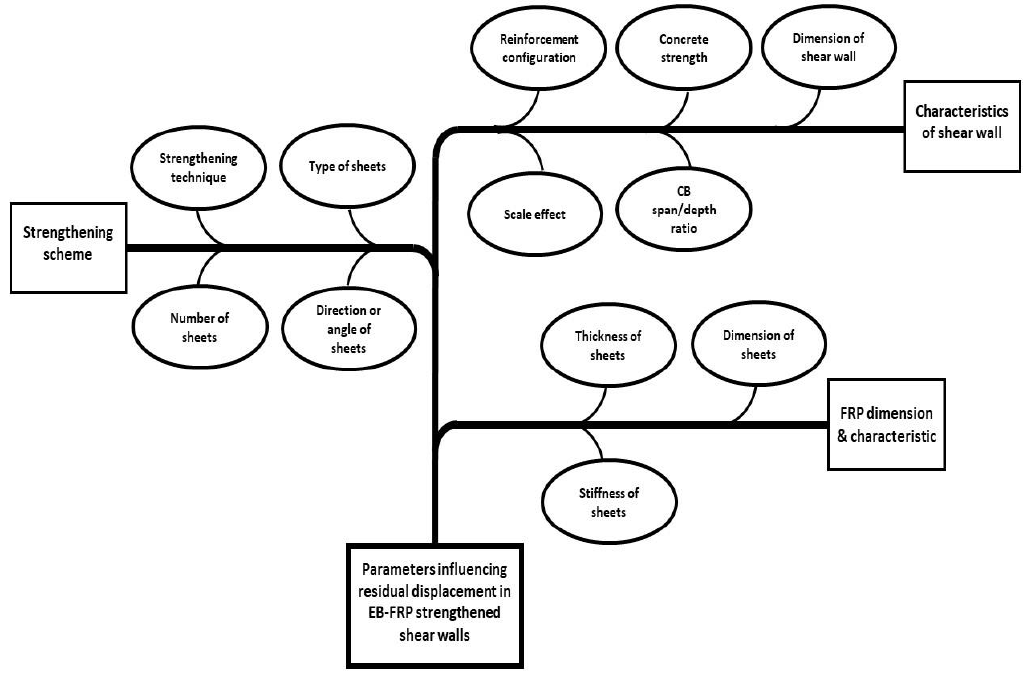
Figure 11. Overview of the parameters influencing residual displacement in EB-FRP strengthened shear walls.